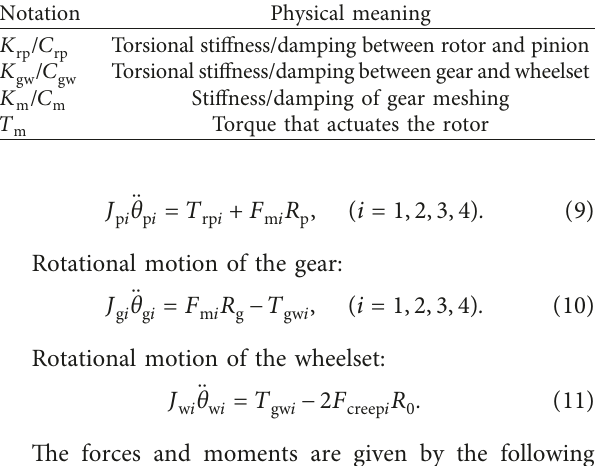
Table 3: Notation used in the gear transmission system.